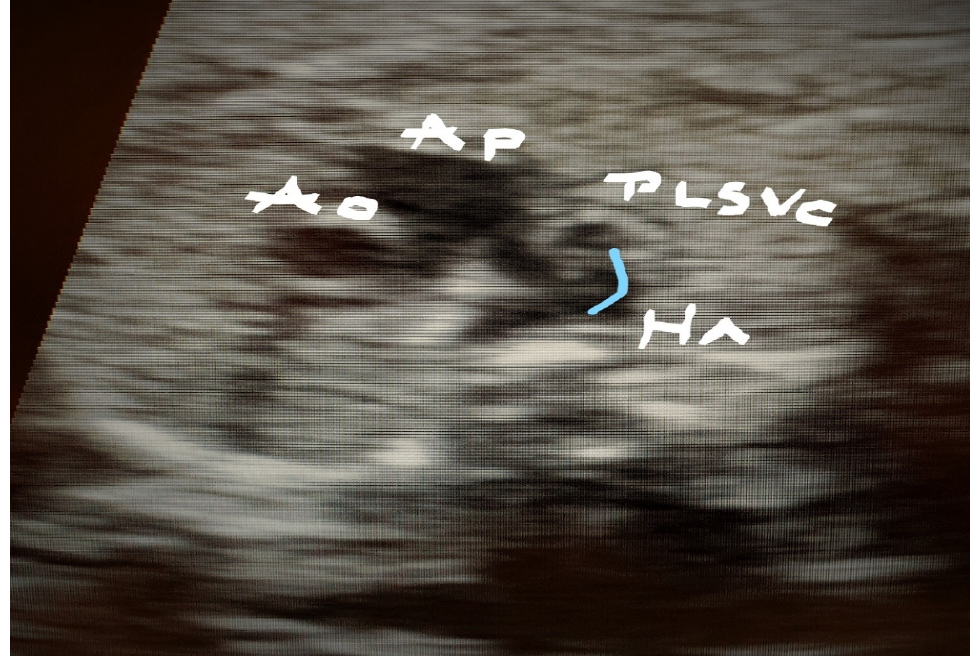
Figure 11. Drainage of the hemiazygos vein in the persistent left superior vena cava (PLSVC). (PLSVC—persistent left superior vena cava, Ao—Aorta, Pa—Pulmonary asrtery, Ha—hemiazygos vein).